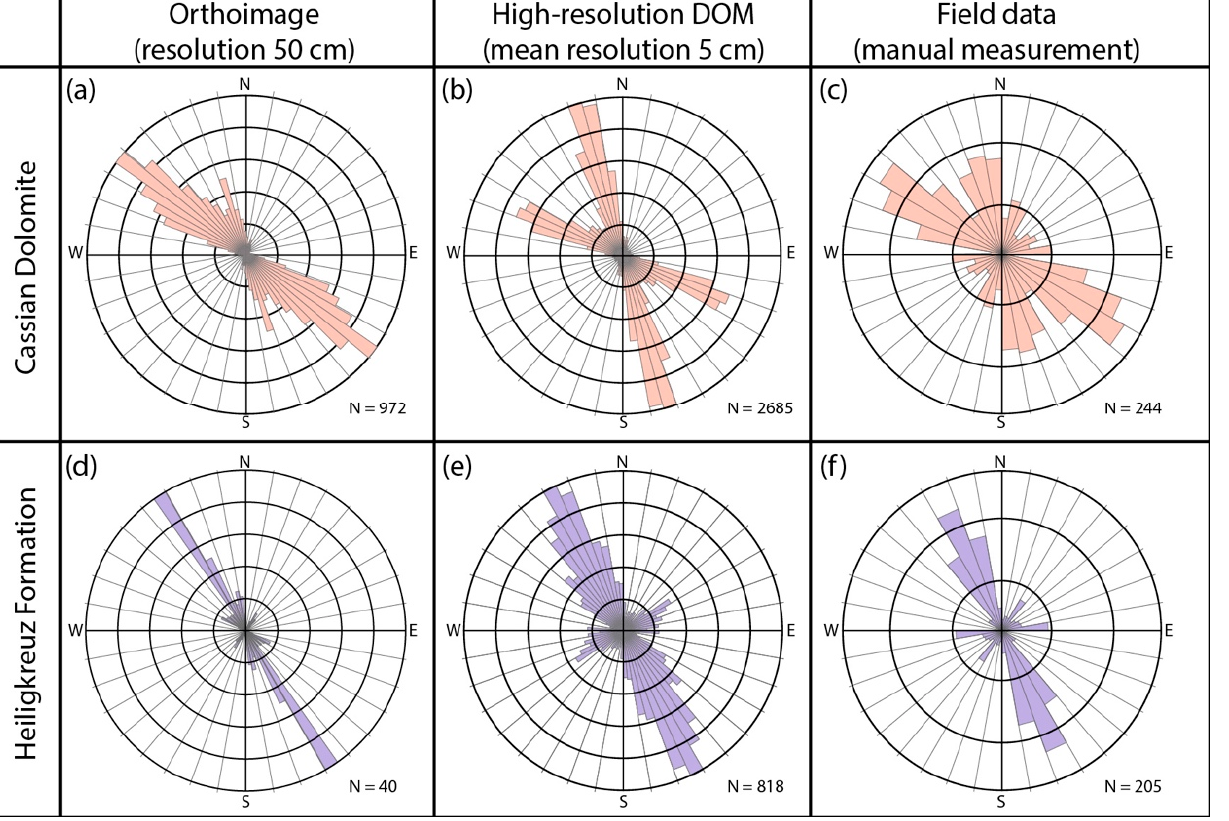
Figure 10. Comparison of the trends of fractures mapped in 2D on the top surface of Cassian platform ( a – c ) and on the overlying Heiligkreuz Fm ( d – f ). Fractures were mapped from the orthoimage ( a , b ), high-resolution DOM ( b , e ), and directly on the outcrop ( c , f ) during the field survey. The roseplots represent the logarithmic frequency for bin size of 10°.